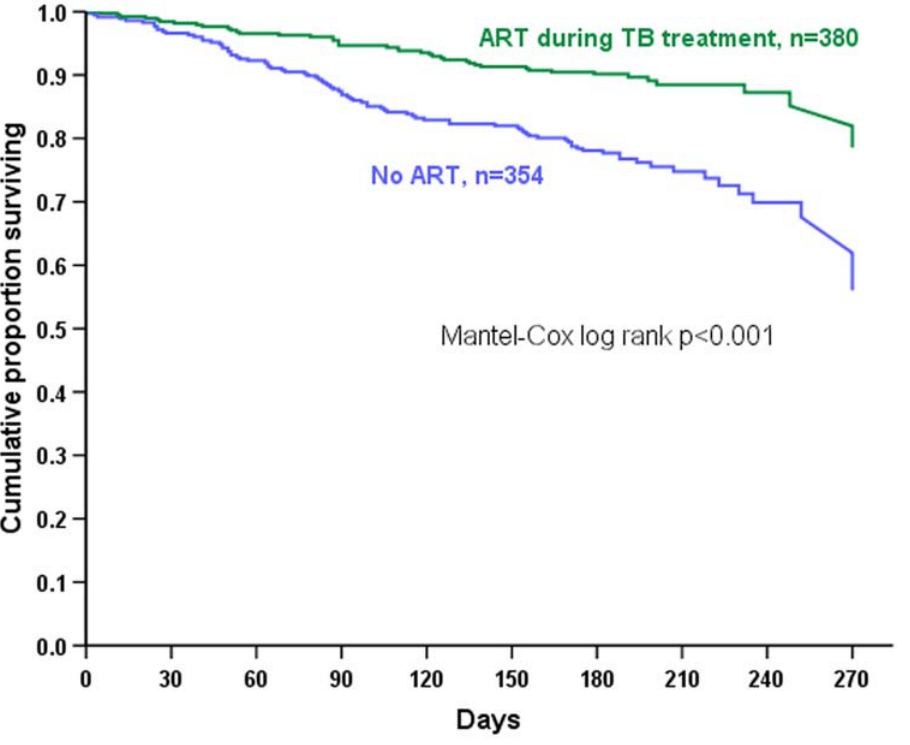
Figure 1. Kaplan-Meier survival curve for HIV-infected TB patients, by exposure to antiretroviral treatment. ART=antiretroviral treatment, TB=tuberculosis.